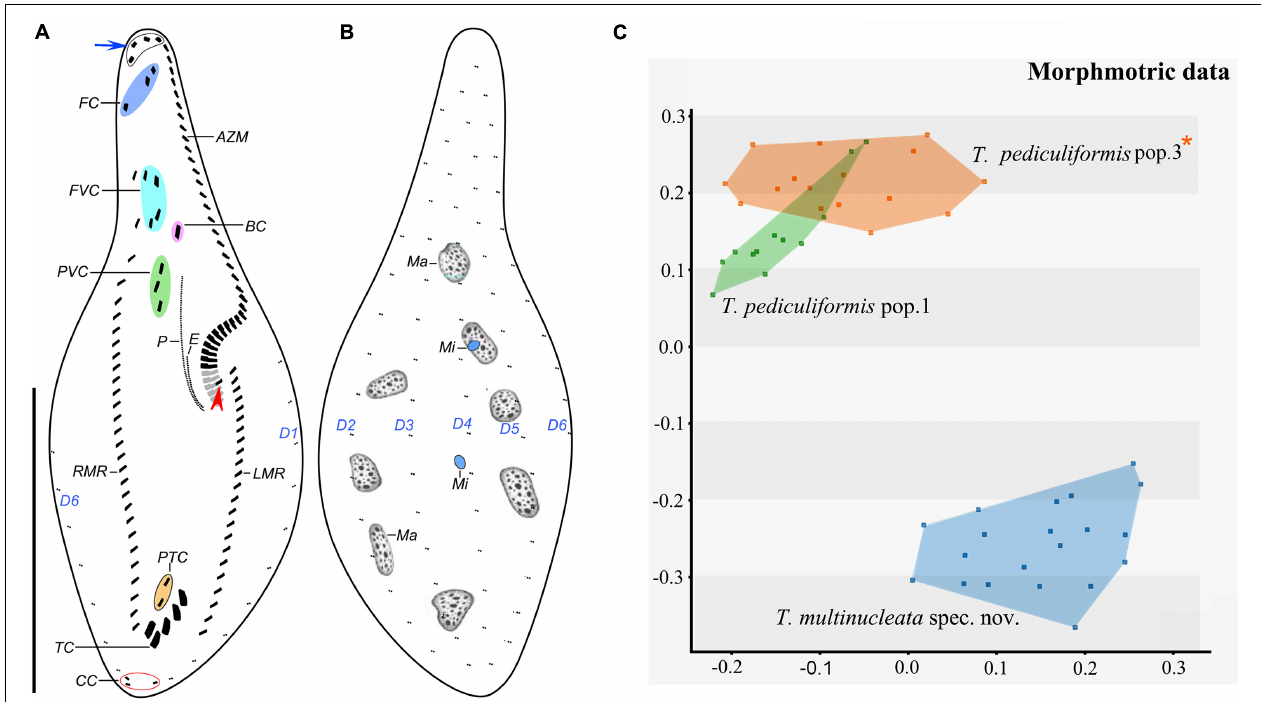
FIGURE 6 | Trachelostyla pediculiformis pop. 1 after protargol impregnation (A,B) and multidimensional scaling of Gower’s similarity matrix based on morphometric data of three Trachelostyla species (C) . (A,B) Ventral (A) and dorsal (B) views of a representative specimen, showing the ciliary pattern and the nuclear apparatus. Blue arrow shows four enlarged adoral membranelles and red arrowhead marks the extra cirrus right of the left marginal cirral row. (C) MDS diagram of 48 individuals based on 13 morphometric features. Trachelostyla pediculiformis pop. 3 marked by red asterisk was a misidentified material in Huang et al. (2016). AZM, adoral zone of membranelles; BC, buccal cirrus; CC, caudal cirri; E, endoral membrane; FC, frontal cirri; FVC, frontoventral cirri; LMR, left marginal cirral row; Ma, macronuclear nodules; Mi, micronuclei; P, paroral membrane; PTC, pretransverse ventral cirri; PVC, postoral ventral cirri; RMR, right marginal cirral row; TC, transverse cirri; D1–6, dorsal kineties. Scale bar = 70 µ